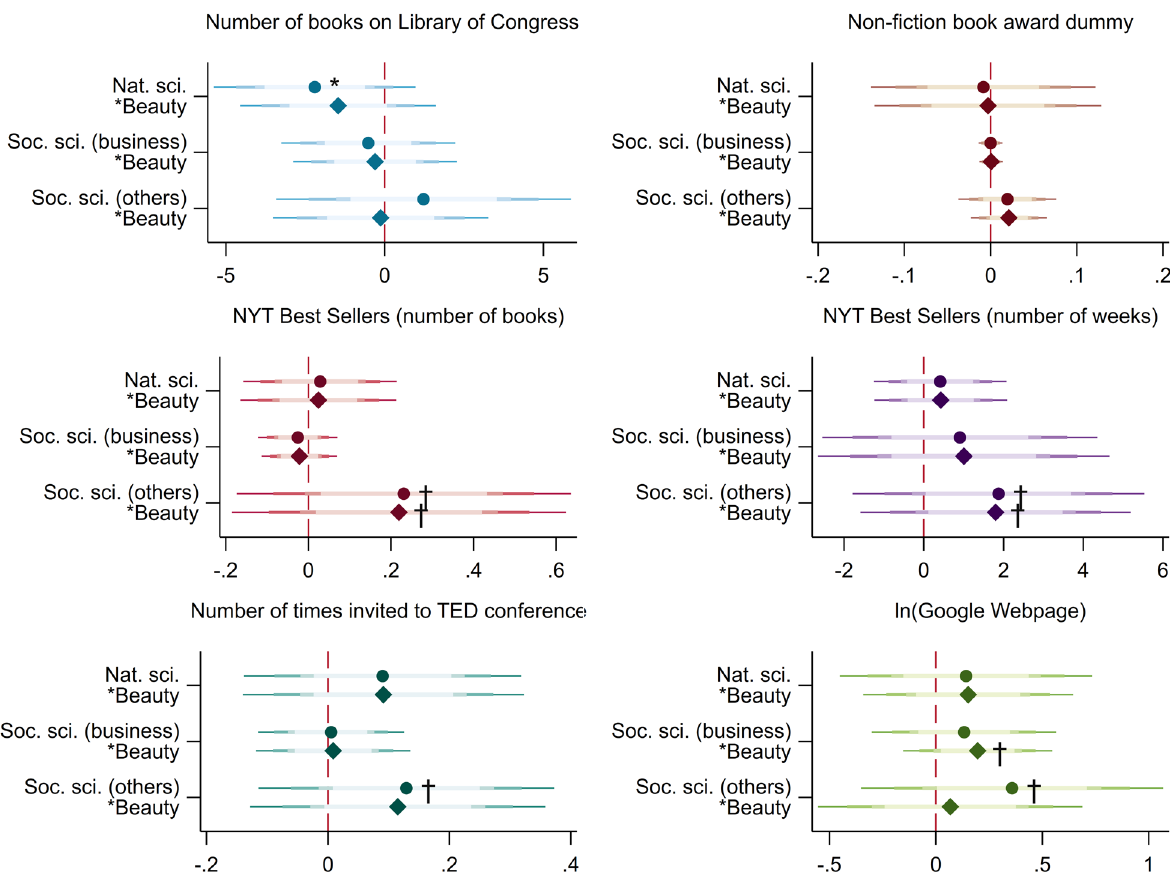
Fig. 1 Effects of facial attractiveness on external in fl uence measures between research fi elds. Coef fi cient estimates based on regression models with facial attractiveness*research fi eld terms from Table 3. Markers (circle = models without controlling for academic productivity; diamonds = models controlling for academic productivity) represent the point estimate of the effect of facial attractiveness on each external in fl uence measure for natural scientists (Nat. sci.*Beauty) and social scientists (Soc. sci. (business/others)*Beauty). Error bars represent 99.9%, 99%, 95%, and 90% con fi dence intervals. † p < 0.10; * p <